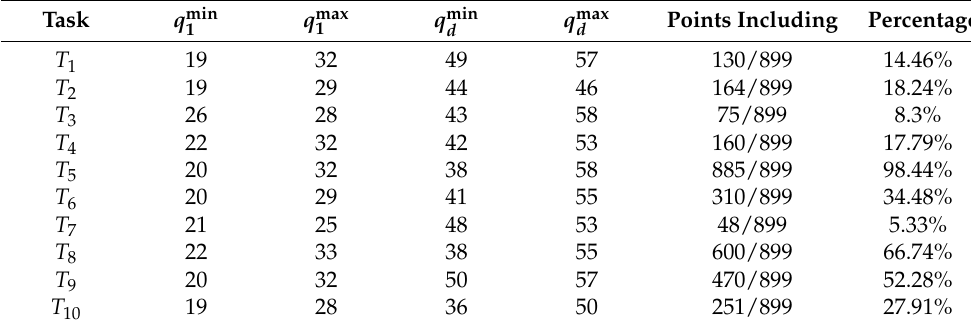
Table 4. Queries generation and percentages of data overlapping